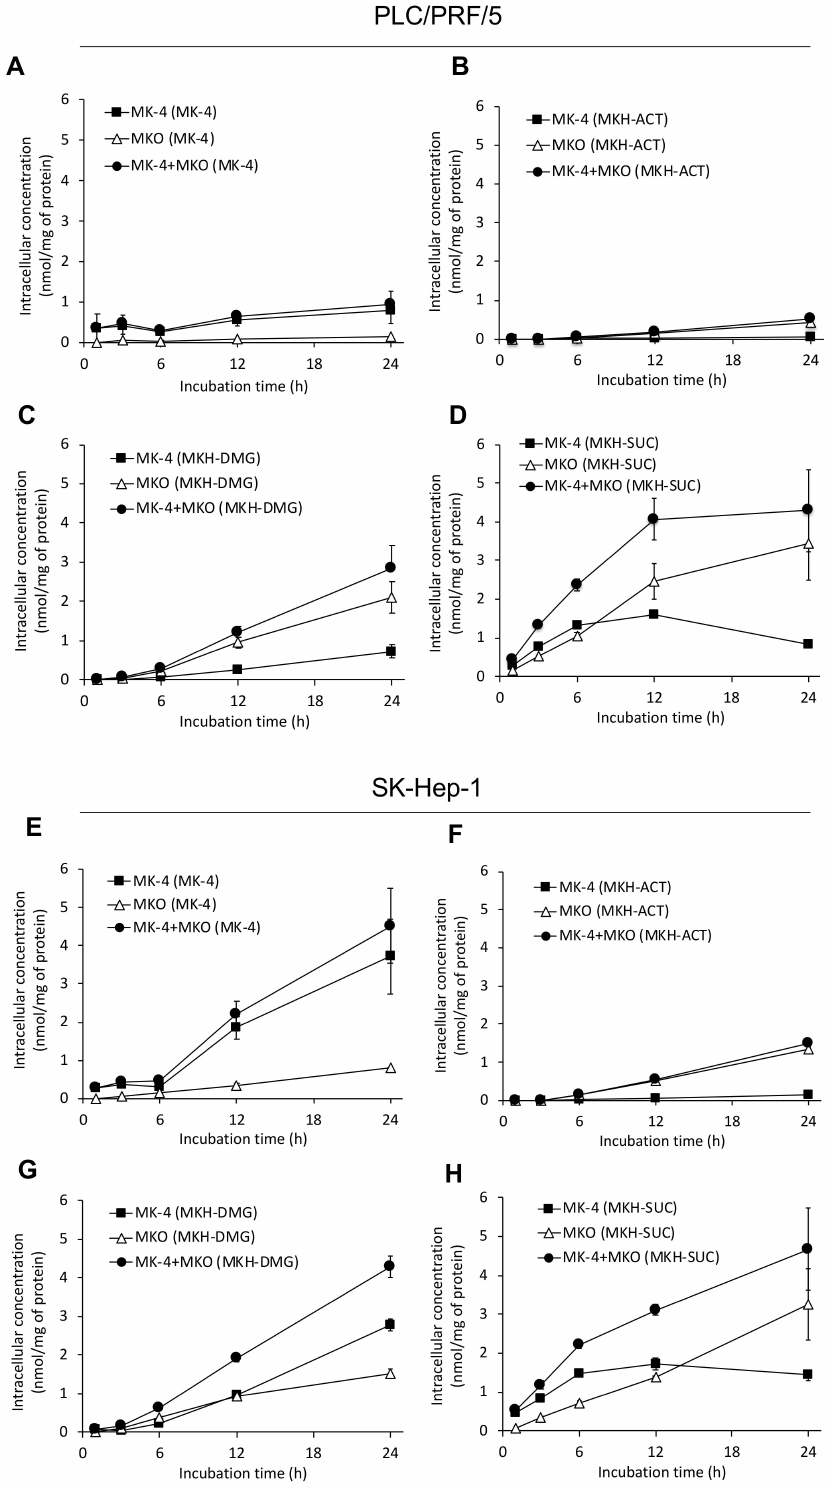
Figure 5. MKH delivery into HCC cell lines via MKH-ester prodrugs or MK-4. Intracellular MK-4 and MKO concentration–time profiles following 25 µ M MKH-ester prodrug or MK-4 treatment of PLC/PRF/5 ( A – D ) and SK-Hep-1 ( E – H ) cell lines. ( A , E ), MK-4; ( B , F ), MKH-ACT; ( C , G ), MKH-DMG; ( D , H ), MKH-SUC. Symbols: (cid:4) , MK-4; (cid:52) , MKO; , MK-4 + MKO after MKH-ester prodrug or MK-4 treatment. Error bars indicate means ± SDs ( n =